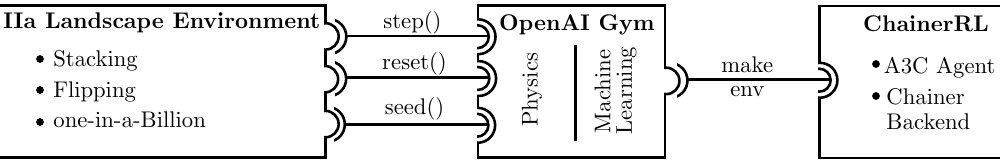
Figure 1 . Interfacing the physics environments with ChainerRL via OpenAI